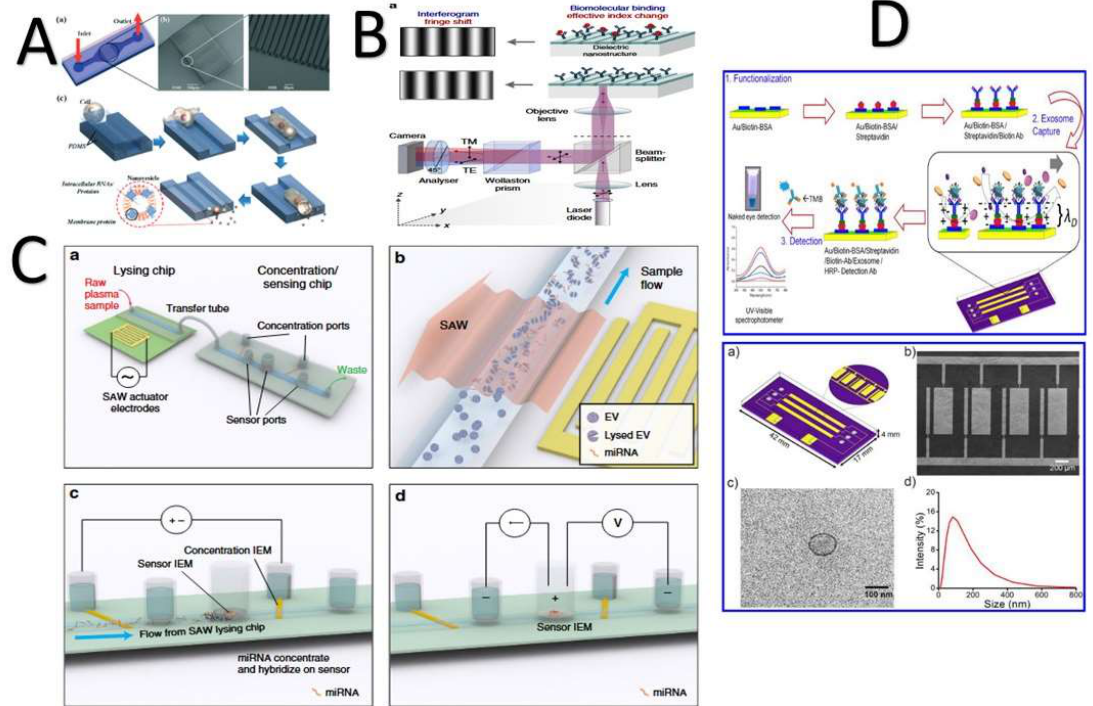
Figure 6. Examples of microfluidic chips for exosome detection and quantification. Figure permissions are as follows: ( A )